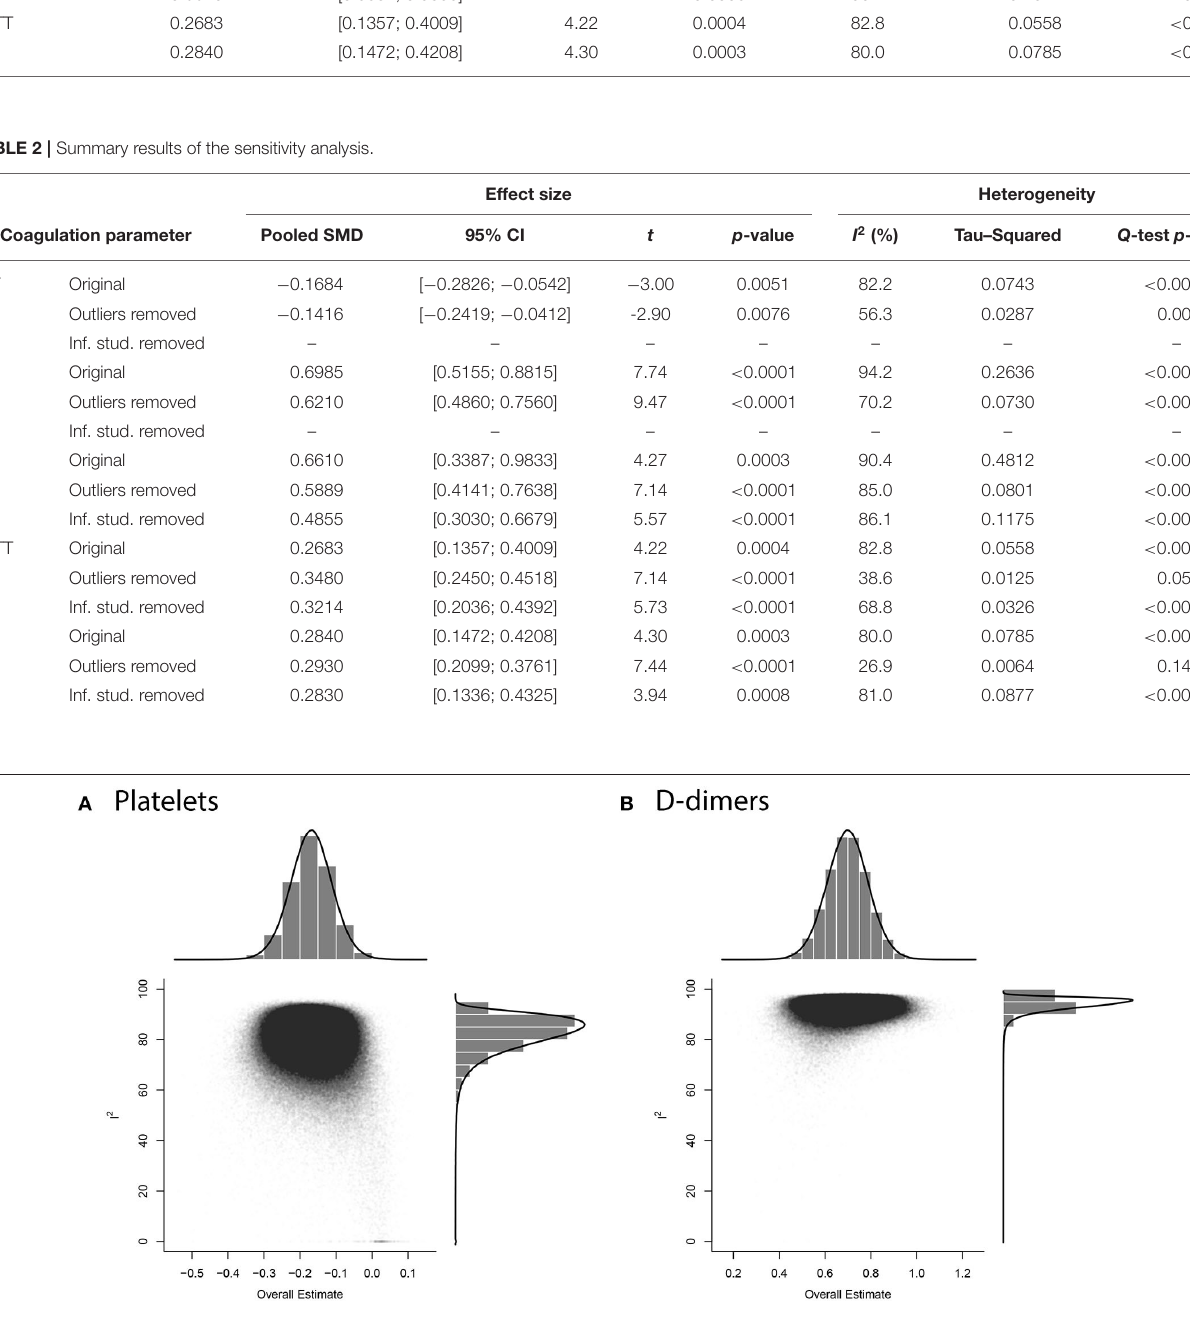
Frontiers in Cardiovascular Medicine |